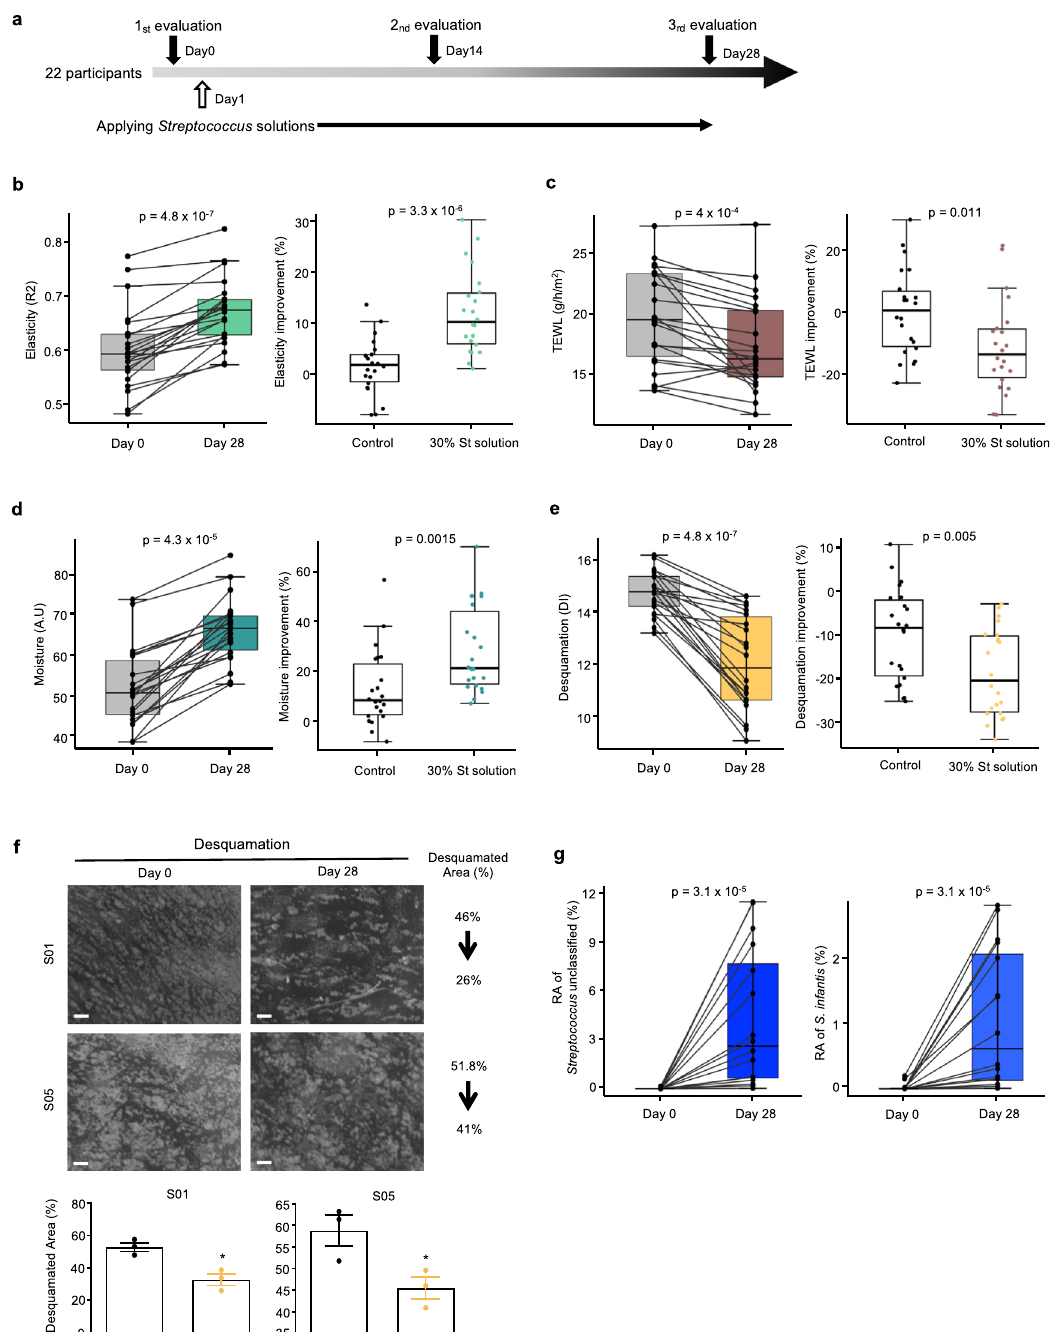
Fig. 3 St solutions clinically improve skin phenotypes. a Scheme of clinical evaluations. b – f Boxplots illustrating facial skin parameters on day 0 and day 28 after the application of the St emulsion (left plots), and in control versus St solution-treated individuals (right plots); n = 22 per group. b Elasticity, c TEWL, d moisture, e desquamation. f Direct observation (top) and comparison (bottom) of desquamation on the cheek surface in participants S01 and S05 on day 0 and day 28 of St solution treatment at ×20 magni fi cation. Three technical observations were done. The white area is corneocyte. Scale bar corresponds to 500 μ m. g Increase in relative abundances of unclassi fi ed Streptococcus and S. infantis on day 28 after application of St solution treatment. The statistical calculation for paired comparison was done using the Wilcoxon signed-rank test, whereas inter-comparison was done using the Wilcoxon – Mann – Whitney test. A.U arbitrary unit, DSC diffuse scattering correction, DI desquamation water loss (TEWL) and horny layer moisture content. TEWL indicates the moisturizing ability and skin barrier function 14,27 . In the St solution-treated cheeks, the TEWL score declined from 19.90 ± 4.23 to 17.44 ± 3.88 g/h/m 2 (difference − 2.45 ± 3.30 or 11.3% reduction) after 28 days (Fig. 3c, left), whereas that in the control did not decrease signi fi cantly (difference – 0.17 ± 2.82 or